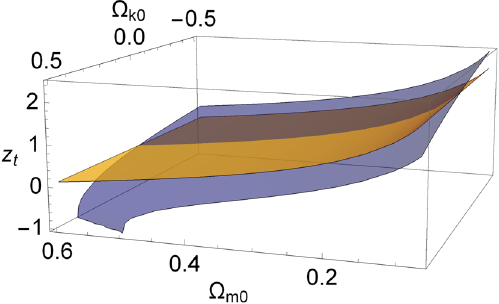
Fig. 1 The blue surface represents the transition redshift as a func- tion of matter and curvature parameters in the non-flat model (cid:2) CDM and the intersection of this curve with the yellow curve represents the transition redshift of the flat (cid:2) CDM